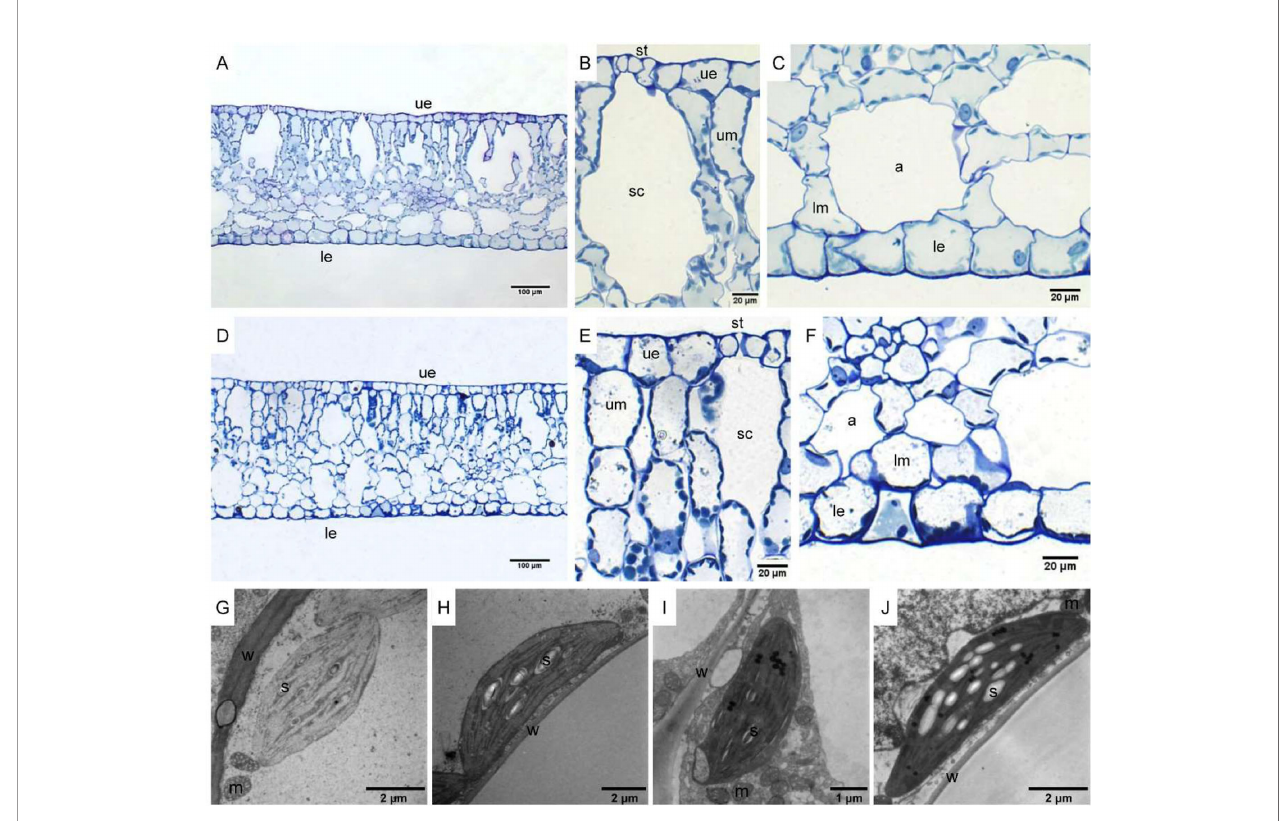
FIGURE 1 | Leaf anatomy and chloroplast ultrastructure of O. cordata fl oating leaves grown at low and high CO 2 . (A – C) Anatomy of O. cordata fl oating leaf grown under low CO 2 . (D – F) Anatomy of O. cordata fl oating leaf grown under high CO 2 . (G) Chloroplast in epidermal cells under low CO 2 . (H) Chloroplast in mesophyll cells under low CO 2 . (I) Chloroplast in epidermal cells under high CO 2 . (J) chloroplast in mesophyll cells under high CO 2 . a, air space; le, lower epidermal cell; lm, lower mesophyll cell; m, mitochondria; s, starch; st, stoma; sc, stomatic chamber; ue, upper epidermal cell; um, upper mesophyll cell; w, cell